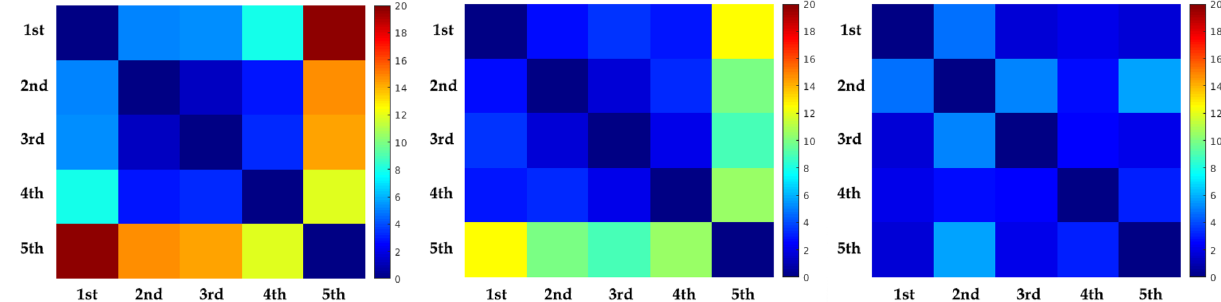
Figure 4. Matrix expressing values of EMD’s for Penetrative, support, and backward passing opportunities respectively. Colors nearer to color dark blue indicate more similarity in between the landscapes while colors nearer to strong red indicate more